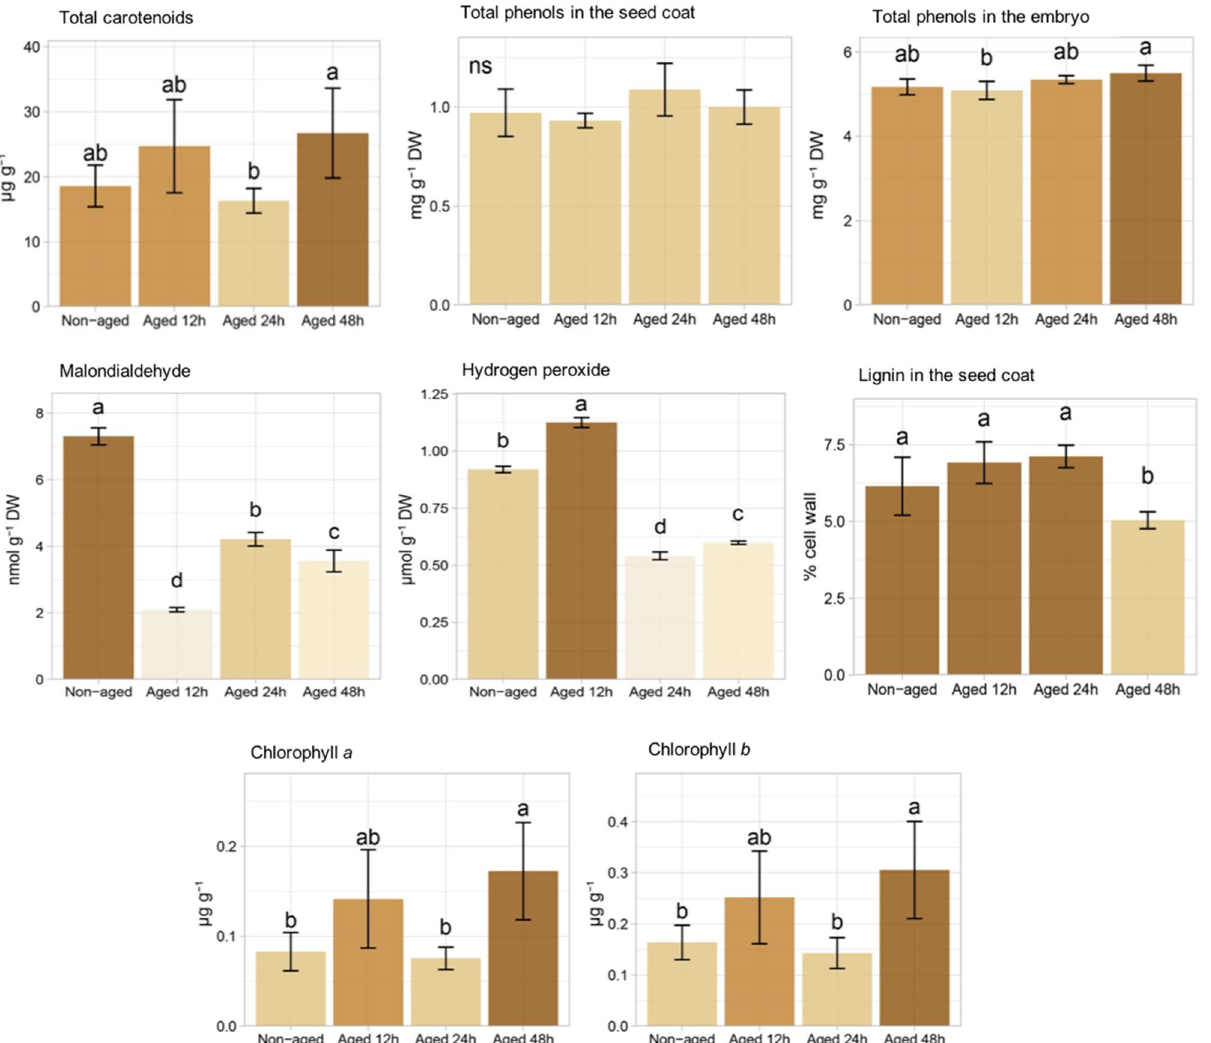
Figure 2. Total carotenoids, total phenols in the seed coat and embryo, malondialdehyde (MDA), hydrogen peroxide (H 2 O 2 ), lignin in the seed coat, chlorophyll a and b of non-aged soybean seeds and seeds aged for 12, 24 and 48 h. Means (± standard deviation) followed by the same letter are not significantly different according to Tukey test ( P <